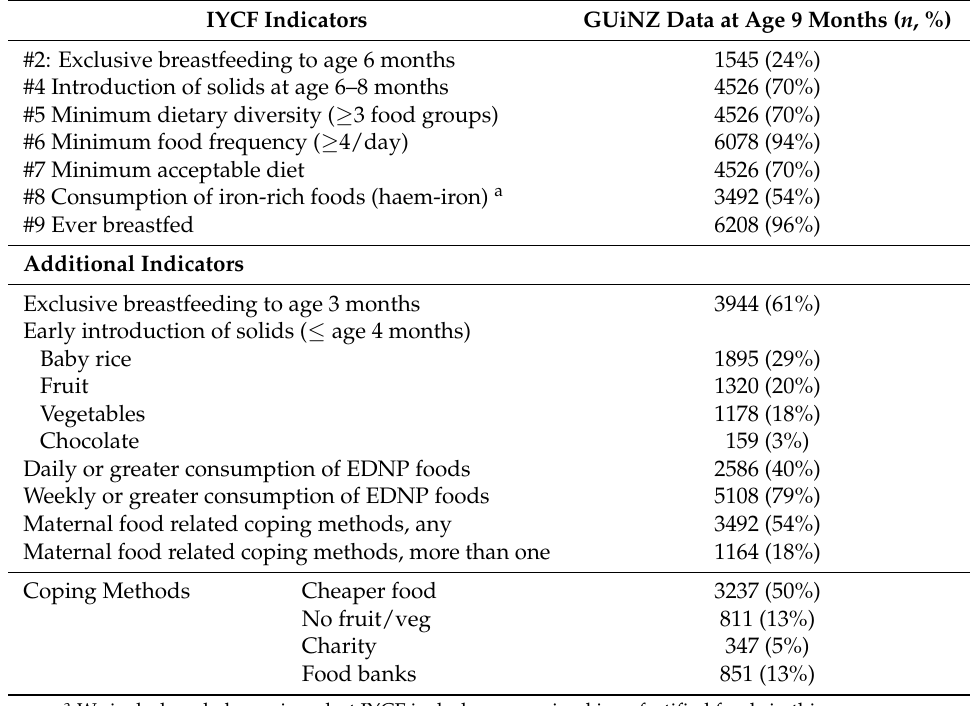
Table 3. Prevalence of Infant and Young Child Feeding Indicators (IYCF) in the Growing Up in New Zealand